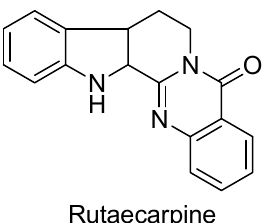
Figure 1. The structure of rutaecarpine.